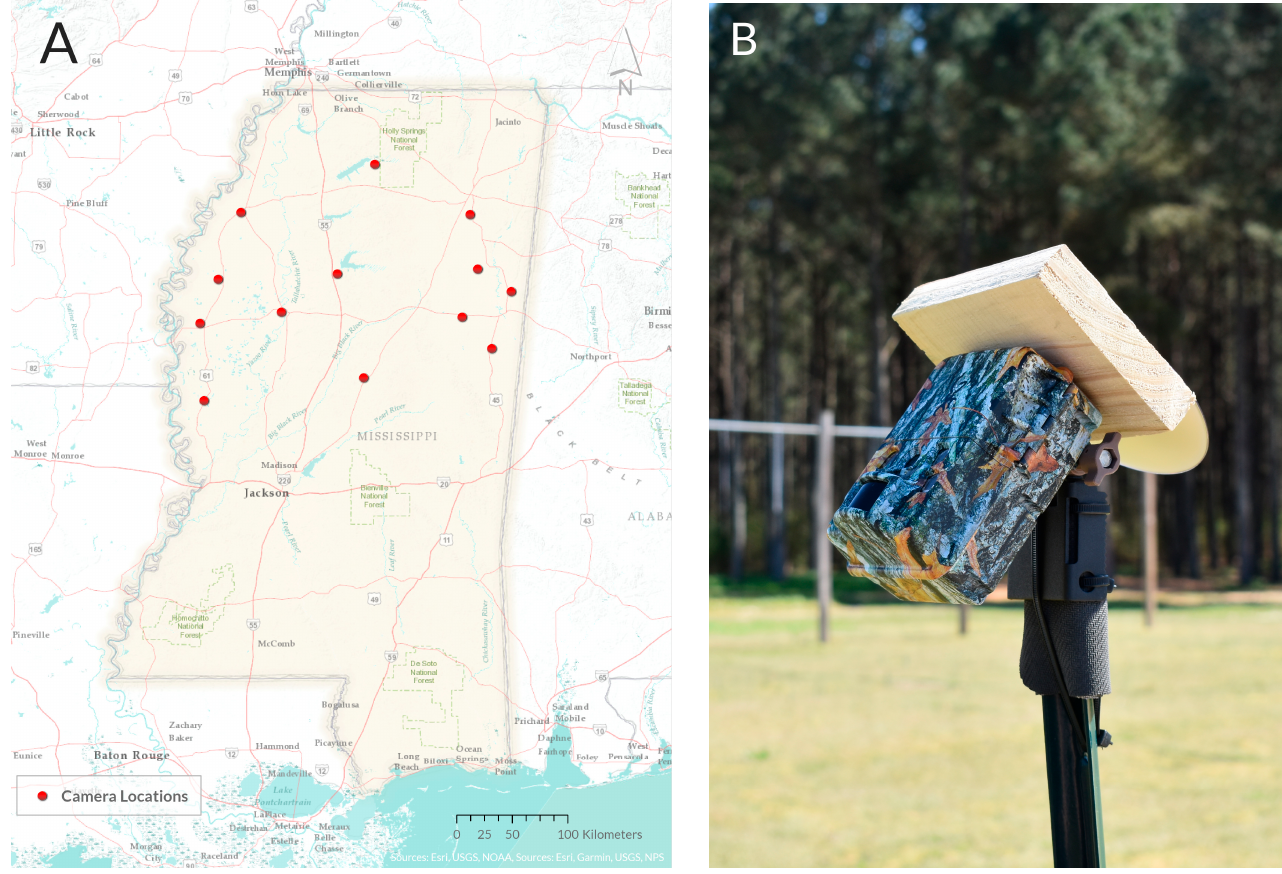
Figure 2. ( A ) The locations of trail cameras used to capture the sky conditions across Mississippi; ( B ) trail cameras were mounted to capture an oblique view of the sky at hourly